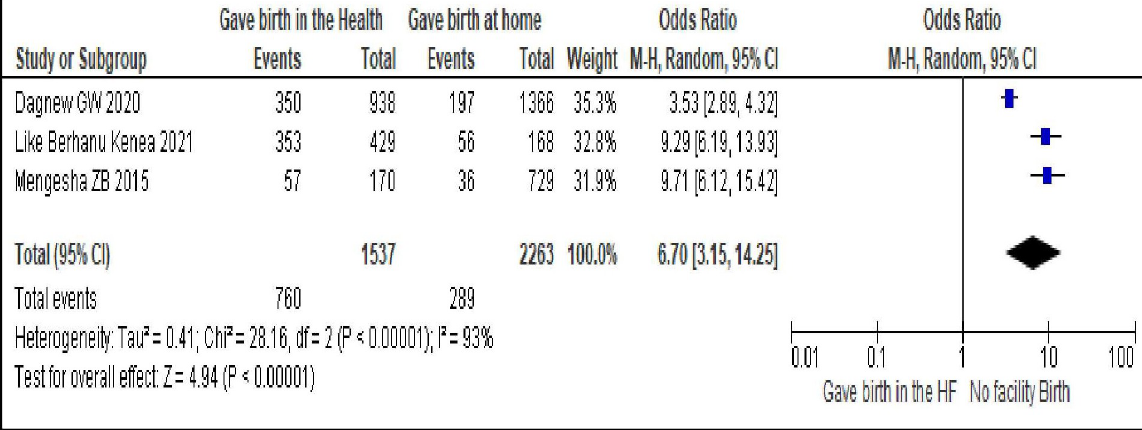
PLOS ONE | https://doi.org/10.1371/journal.pone.0270055 February 7,